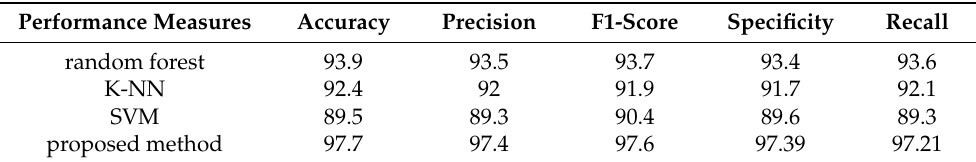
Table 4. The performance metrics of shallow machine learning models compared with our proposed method.